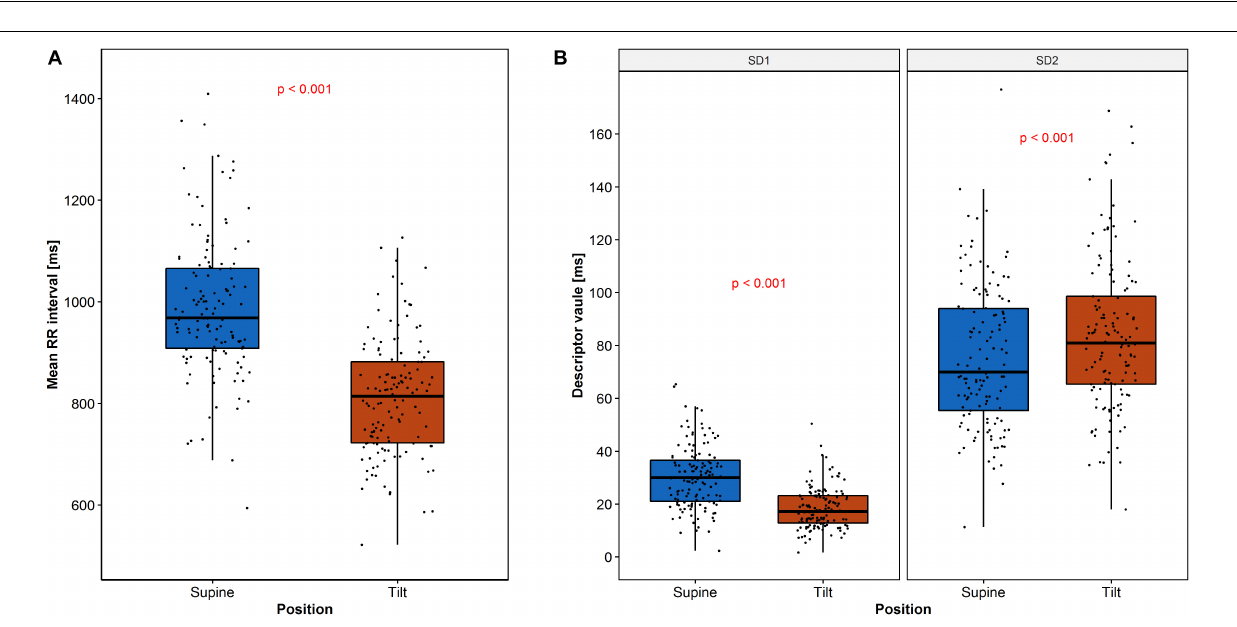
FIGURE 3 | An example of change of PP shape during 5-min recordings in two phases of HUTT: (A) supine and (B) tilt.